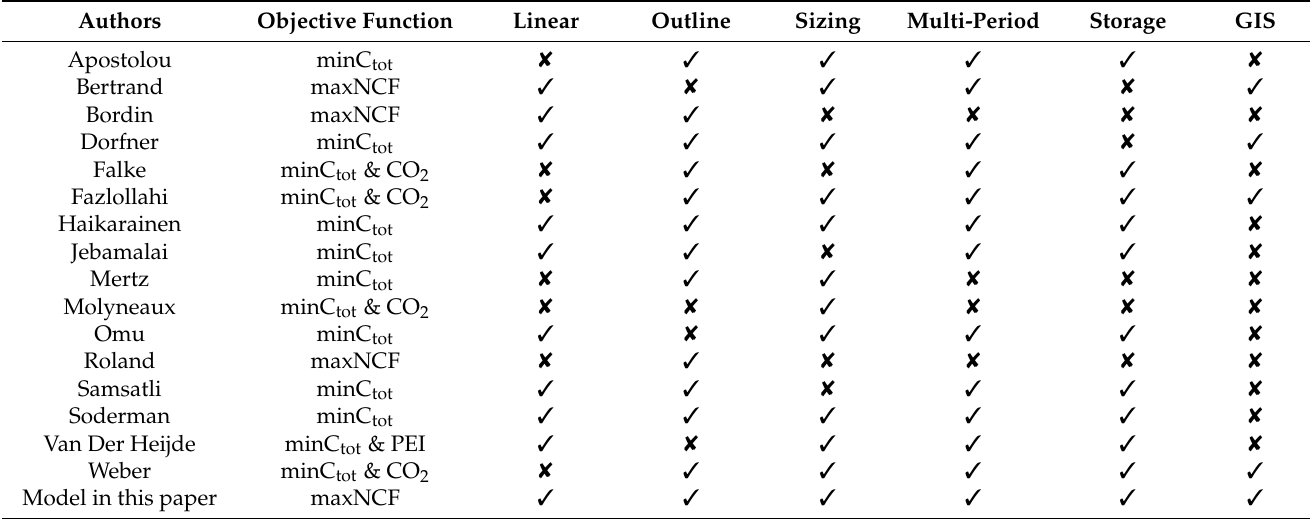
Table 2. Review of the existing optimization